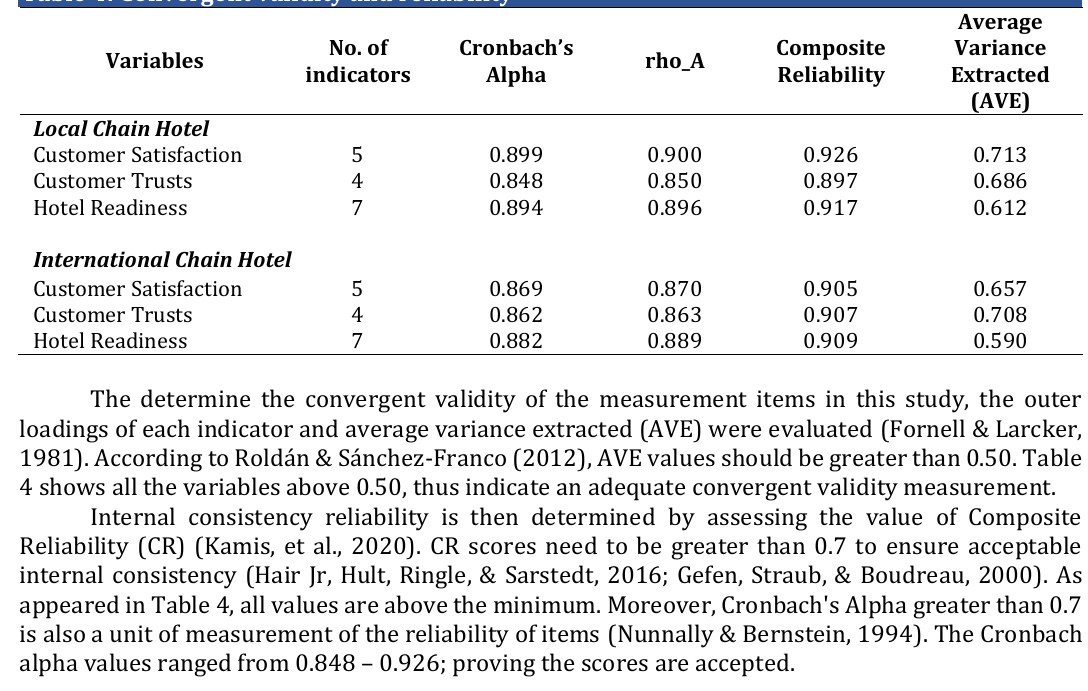
Table 4: Convergent validity and reliability